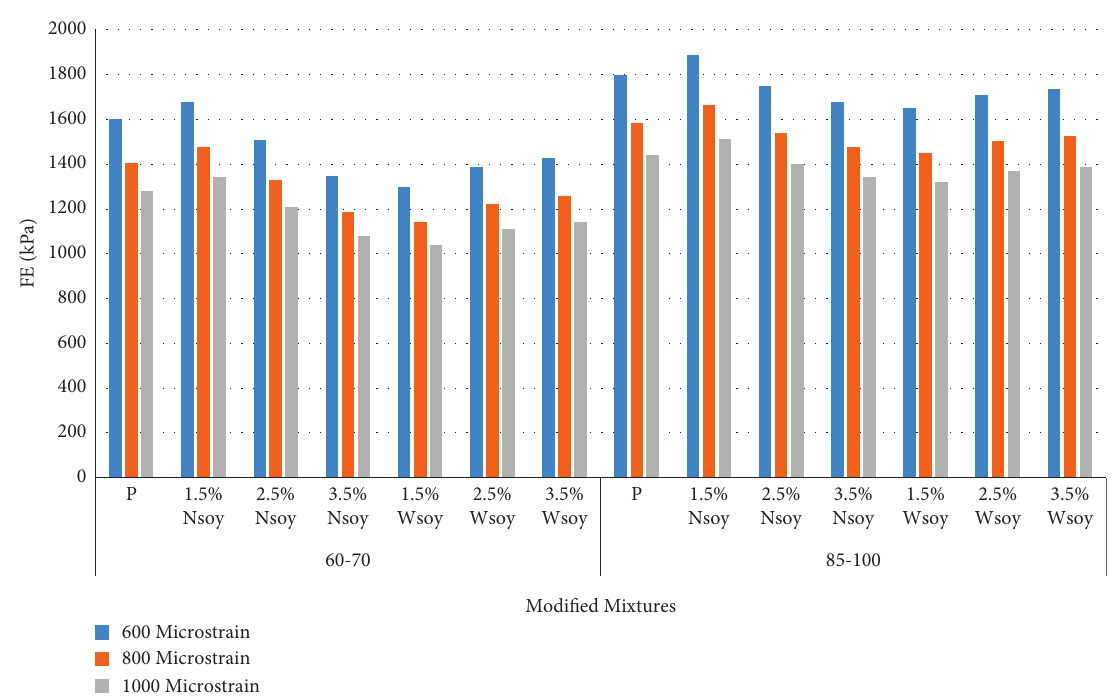
Figure 13: Unmodified and modified mixtures’ fracture